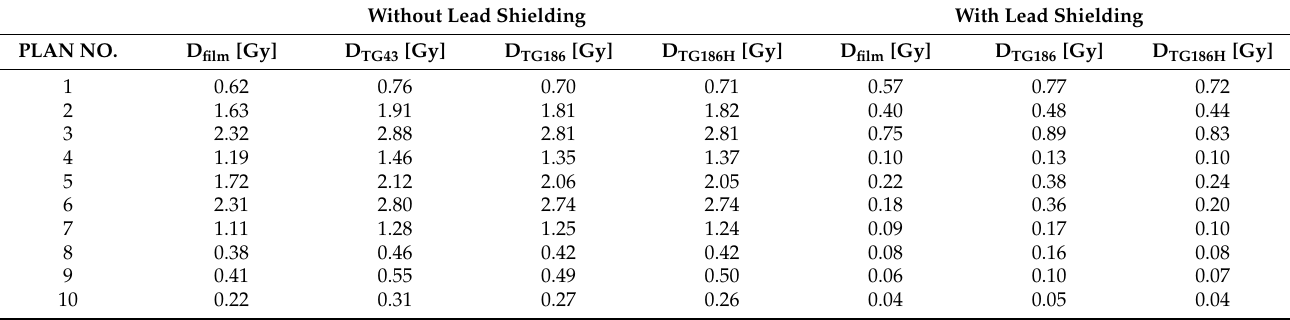
Table 4. Dose values measured and calculated at a point on the eyelid